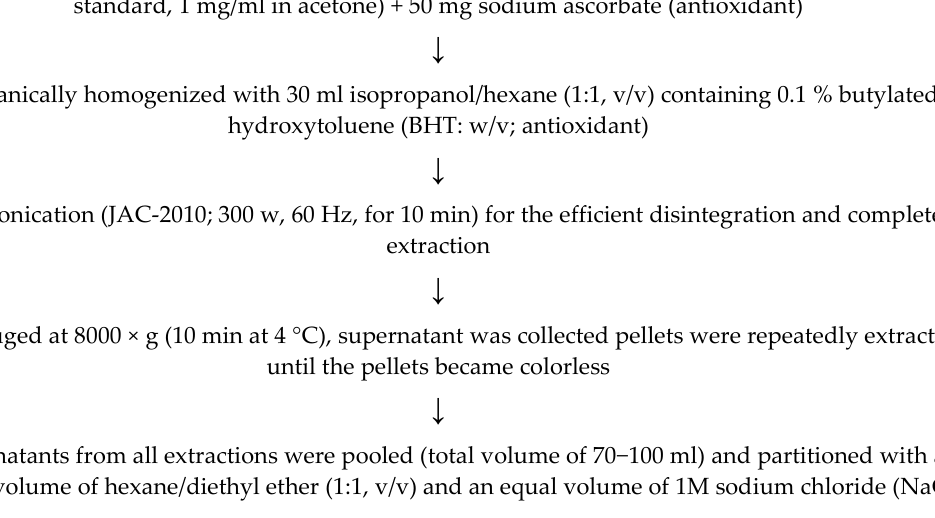
Simultaneous extraction of major lipophilic compounds